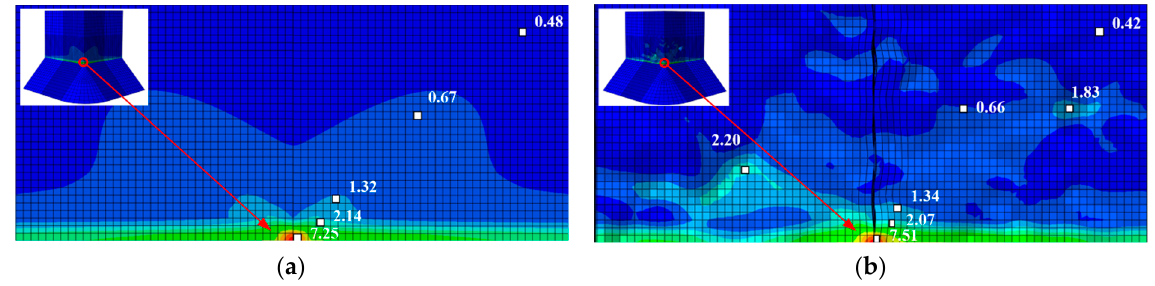
Figure 13. Distribution of equivalent plastic strain ε p at the weld toe corner of the pier: ( a ) ε p of uncorroded pier; ( b ) ε p of corroded pier A1 when cracked.